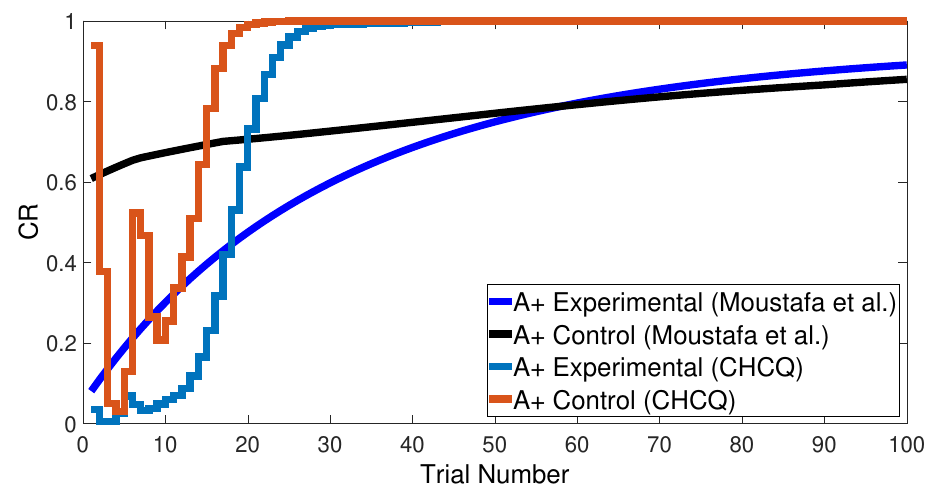
Figure 24. Latent inhibition task for the intact system.